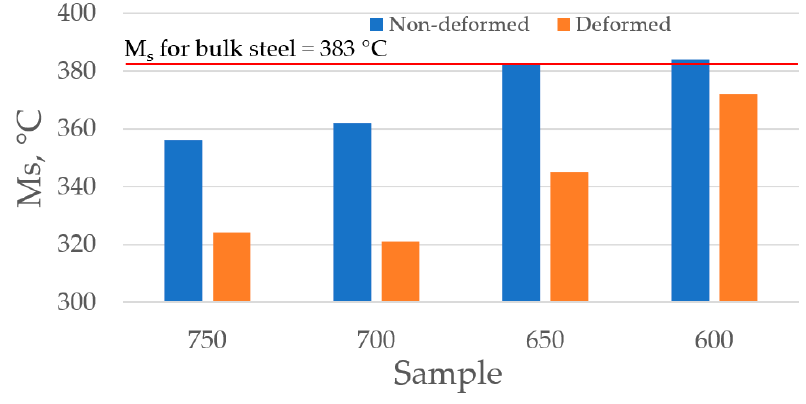
Figure 10. Comparison of M s temperatures for both groups of samples.